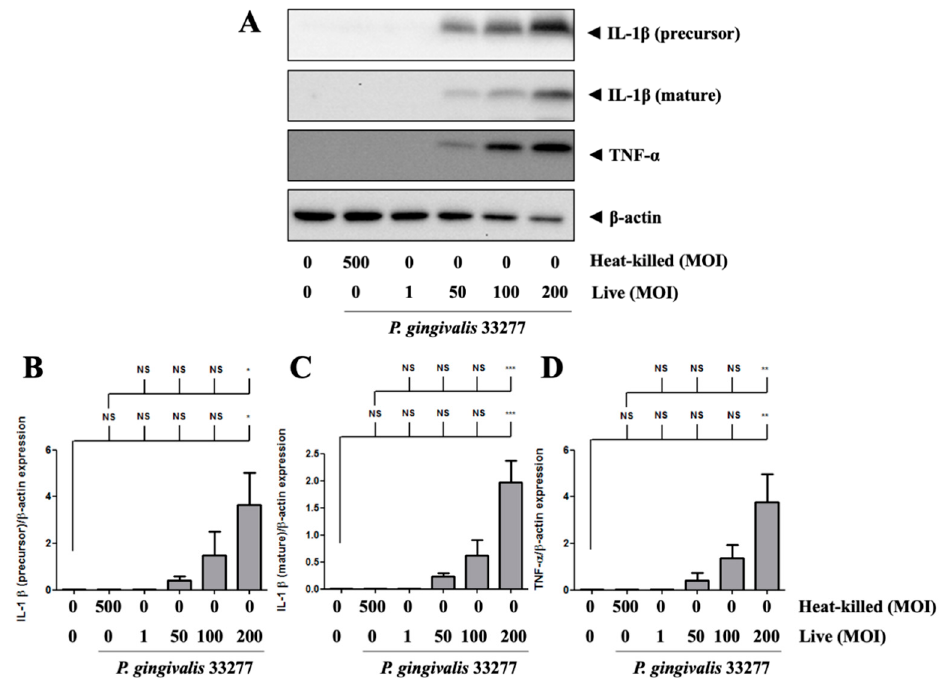
Figure 4. P. gingivalis up-regulated IL-1 β and TNF- α protein levels in bEnd.3 cells. ( A ) Cells are infected with live (MOI 1, 50, 100 and 200) or heat-killed (MOI 500) P. gingivalis for 90-min followed by 24-h fresh medium incubation. Protein expressions of IL-1 β (precursor), IL-1 β (mature), TNF- α , and β -actin are determined using Western blot analysis. The quantitative results were shown in bar graph ( B – D ). Data are presented as mean values ± SEM ( n = 3). Significance differences of the control or heat-killed P. gingivalis group are expressed as *, p < 0.05; **, p < 0.01; ***, p < 0.001 and NS, p > 0.05.